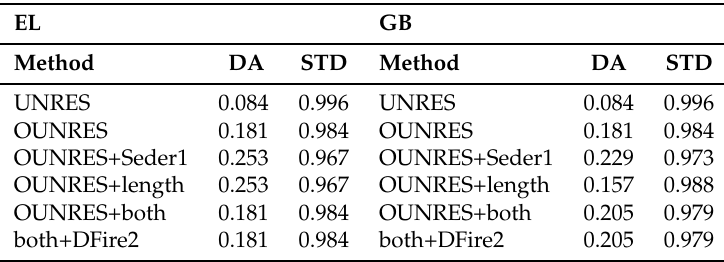
Table 6. Directional Accuracy (DA).